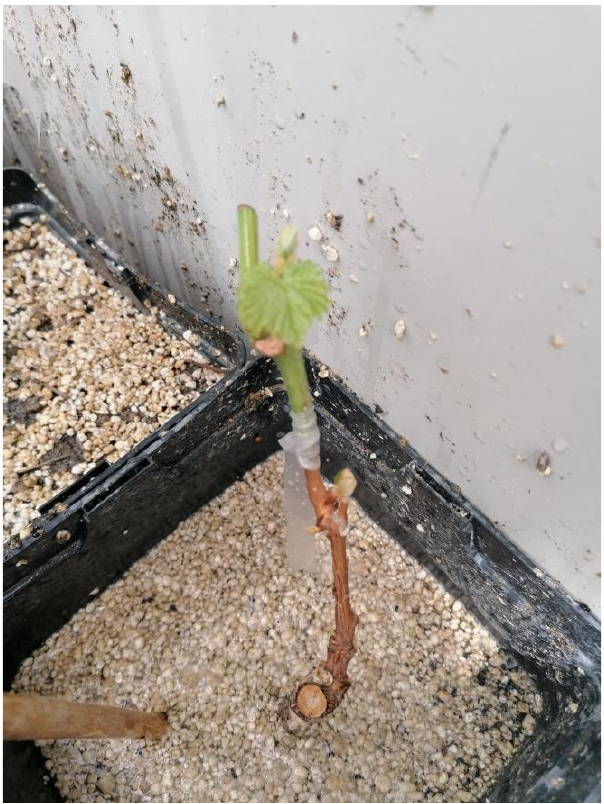
Figure 7. Green grafted Vitis vinifera plant for the purpose of virus transmission.